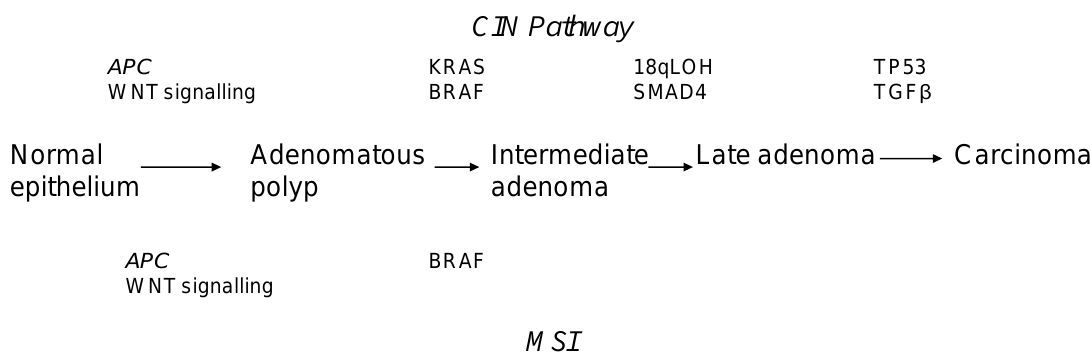
Figure 1. The modified Fearson and Volgenstein Model. Colorectal cancer (CRC) progression can occur through either the chromosomal instability (CIN) or microsatellite instability (MSI) pathway. Early adenomatous changes are secondary to loss of APC. KRAS loss initiates the formation of larger adenomas in the CIN pathway followed by 18qLOH. Mutations in TP53 are a late change. Sporadic MSI tumors are commonly part of the serrated neoplasia pathway and BRAF mutations are more common